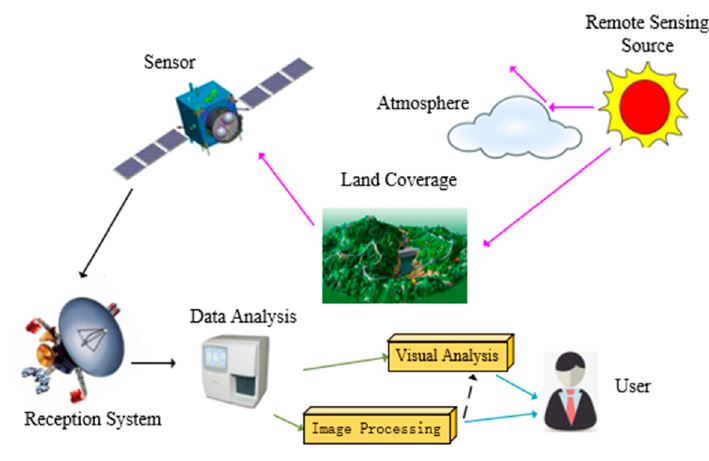
Figure 1. Block diagram of remote sensing systems framework.